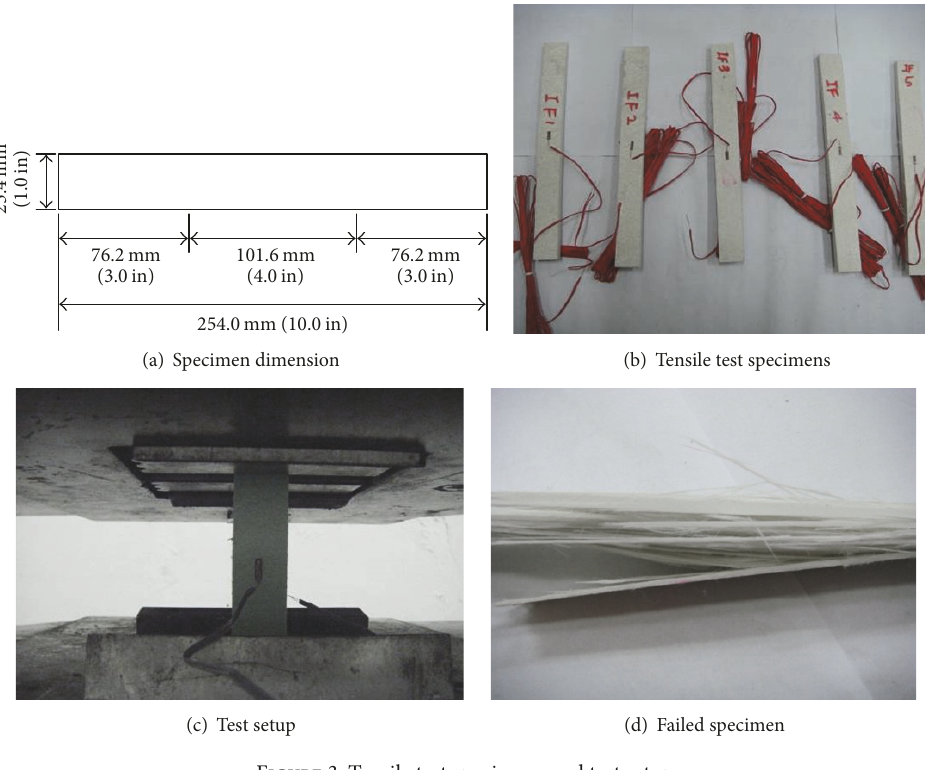
Figure 3: Tensile test specimens and test setup.